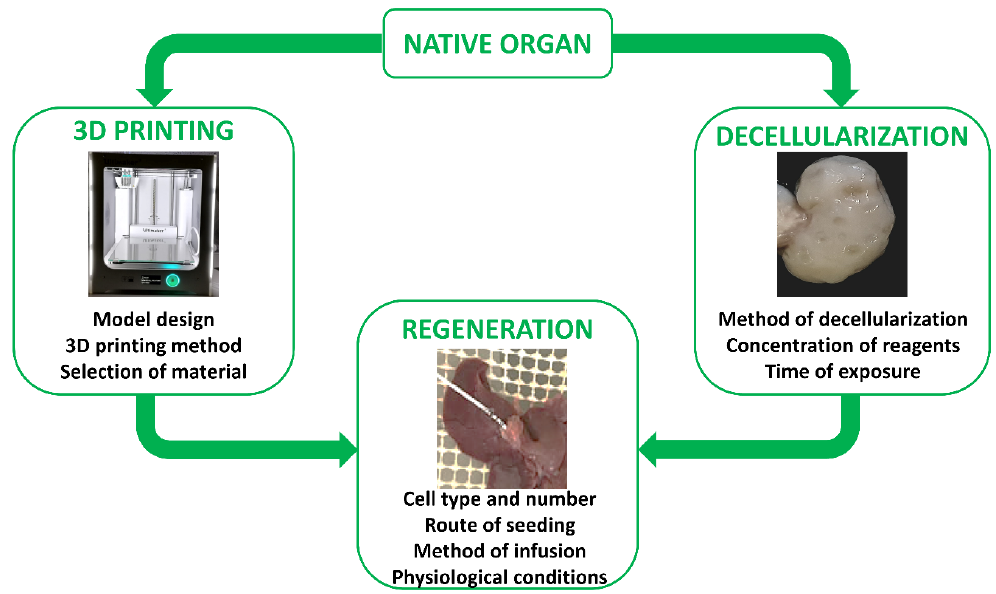
Figure 4. The two main ways and essential key aspects to successfully recreate in vitro a fully functional bio-artificial organ.